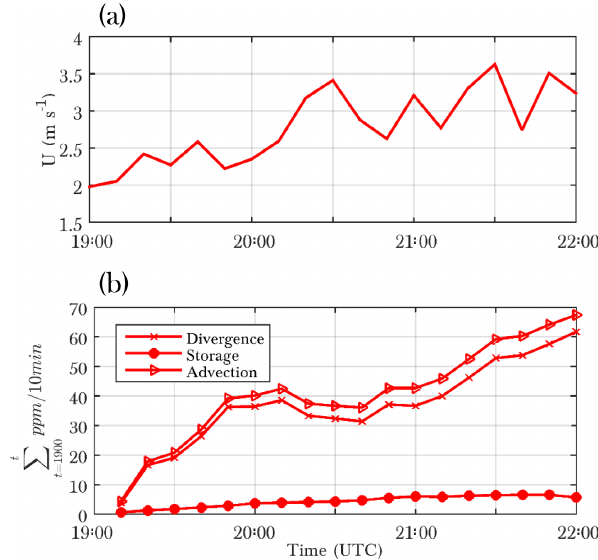
Figure 12. Time evolution between 19:00 and 22:00UTC for the in- tense downslope event of (a) the wind speed ( U ) at 6m and (b) the different terms of the CO 2 budget from Eq. (5). Note that the cumu- lative sum from 19:00UTC is represented in panel (b) , and that the advection term, which is negative, is shown in absolute